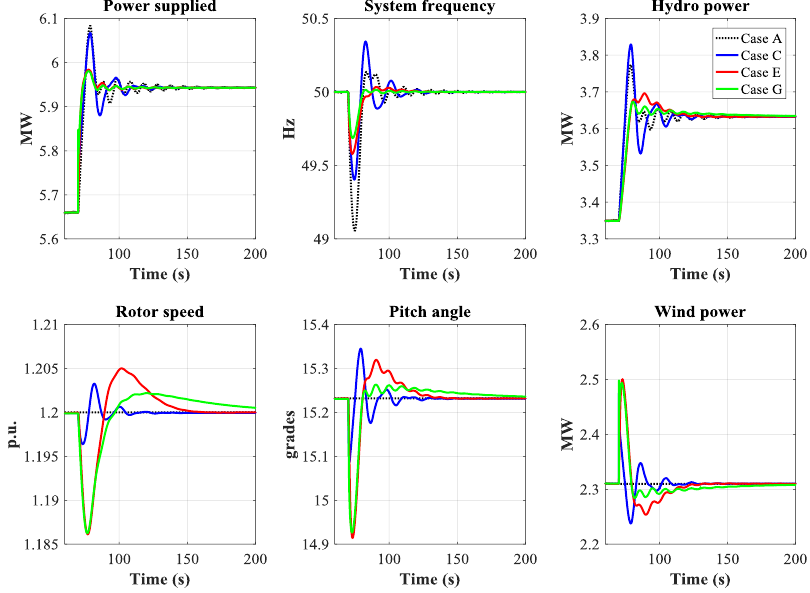
Figure 10. Comparison of the dynamic response of the system between the base case and the case in which the VSWT contributes to frequency regulation by combining the inertial and proportional control, and by considering a sudden power demand variation and a constant wind speed of w s = 20 m/s.